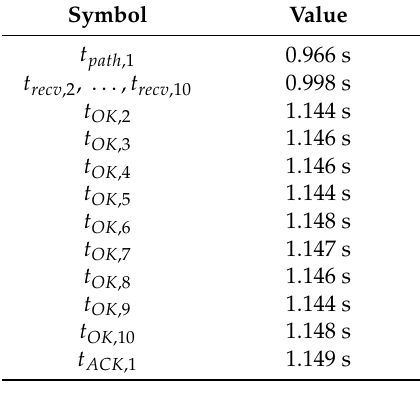
Figure 6. Time sequence diagram of the lane change protocol in the preparation section. Table 2. Symbols in the preparation section.